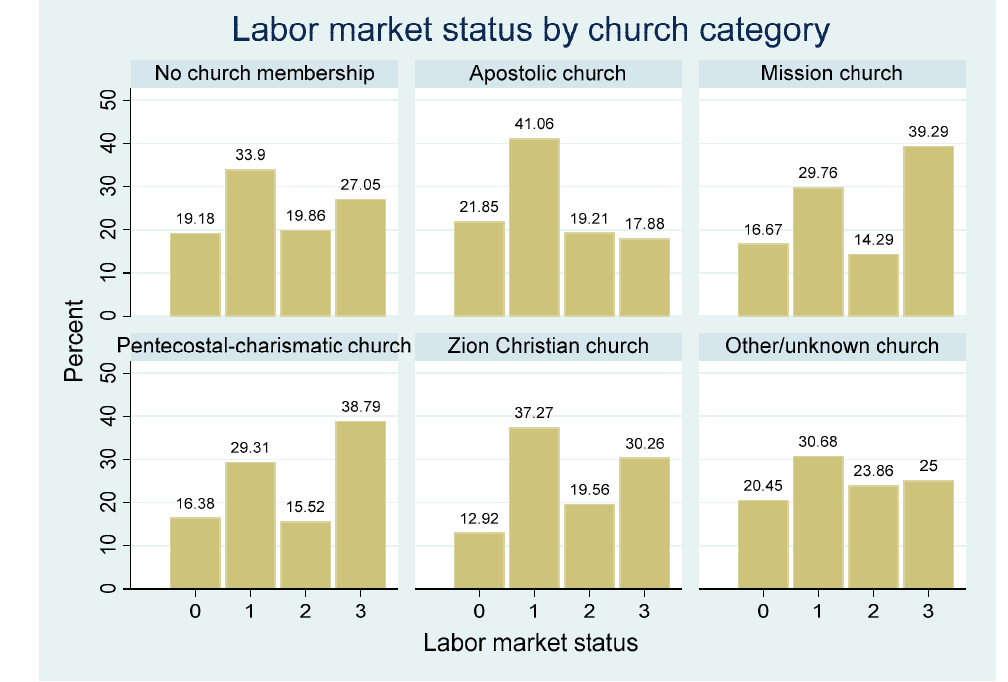
Figure 3. Labor market status by church membership. Note—Figure shows the distribution of labor market status according to church category. Labor market status 0 indicates not working and not actively looking for work, 1 indicates not working but actively looking for work, 2 indicates employment or self-employment in the informal sector, 3 indicates formal sector employment or self-employment.